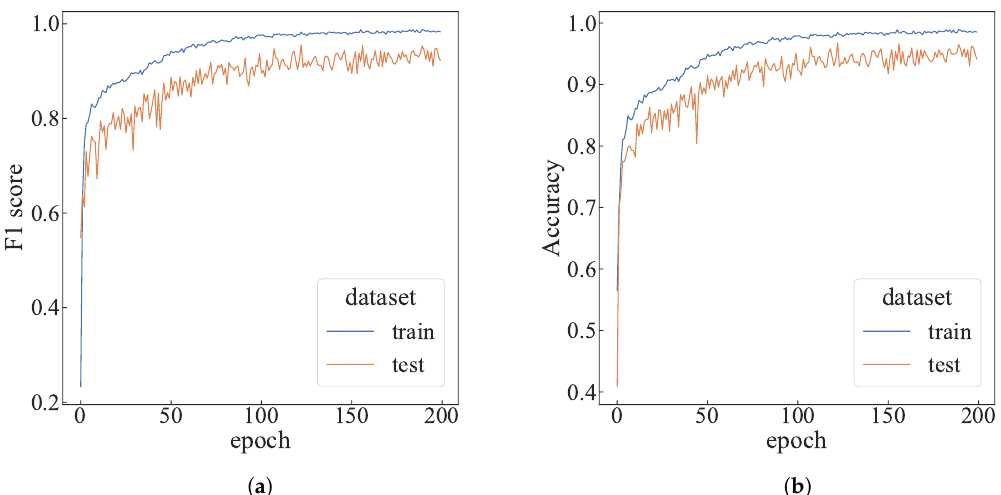
Figure 8. The performance of default settings. ( a ) F 1-score of default settings; ( b ) accuracy of the default settings.